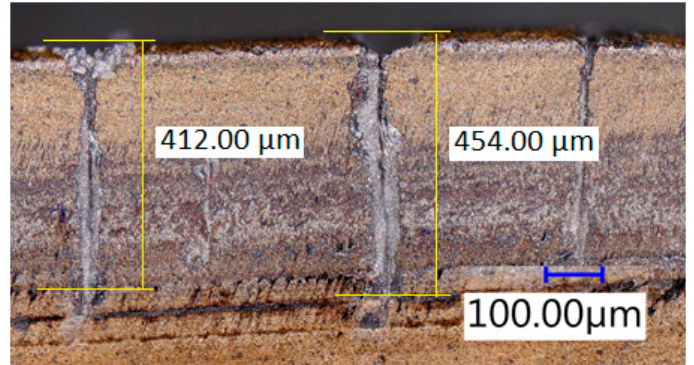
Figure 4. Measurement methods of the length of thermal cracks. Table 8. Average length of thermal cracks.